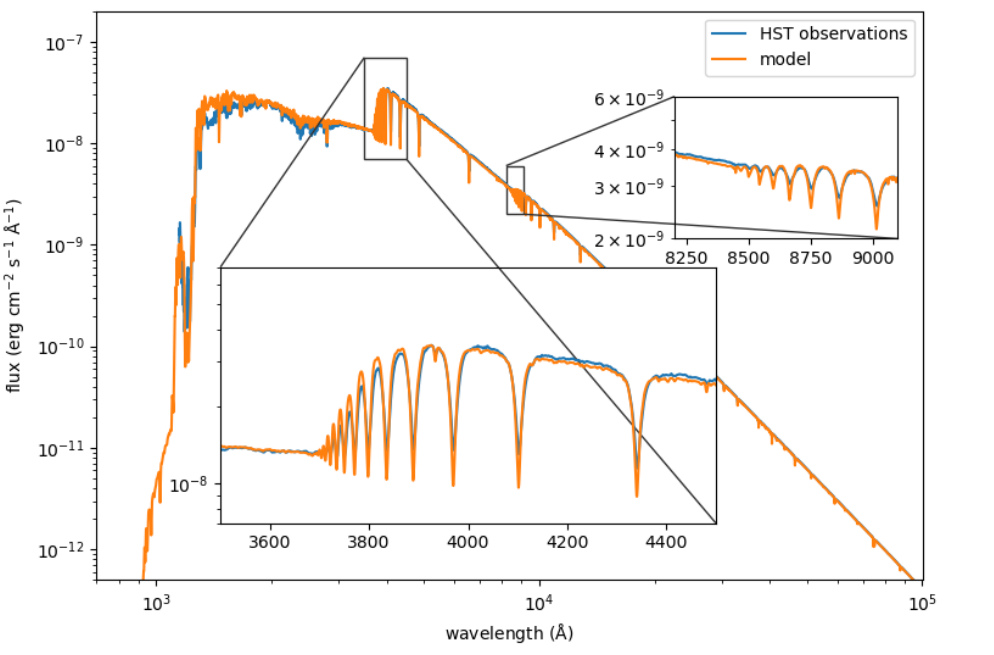
Figure 5. Observed (blue) and model (orange) spectra for the A-type Sirius A. The model has been scaled using the determination of the star angular diameter by